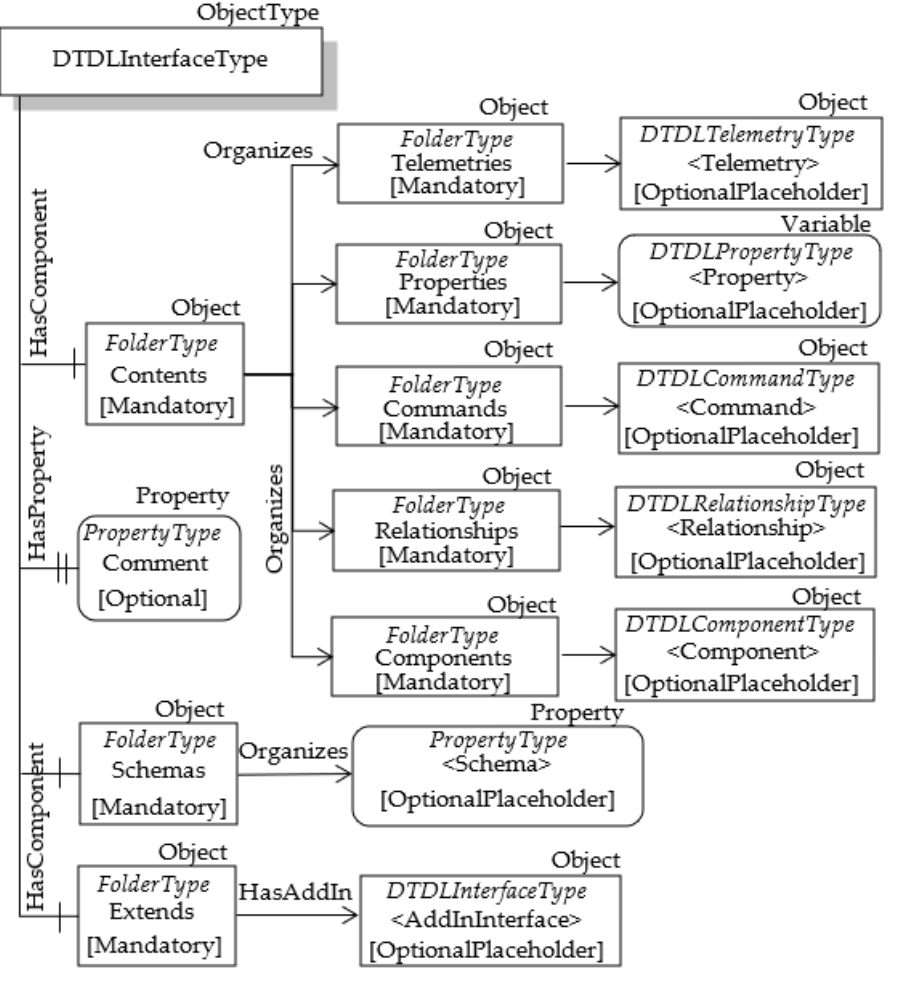
Figure 4. OPC UA DTDLInterfaceType.